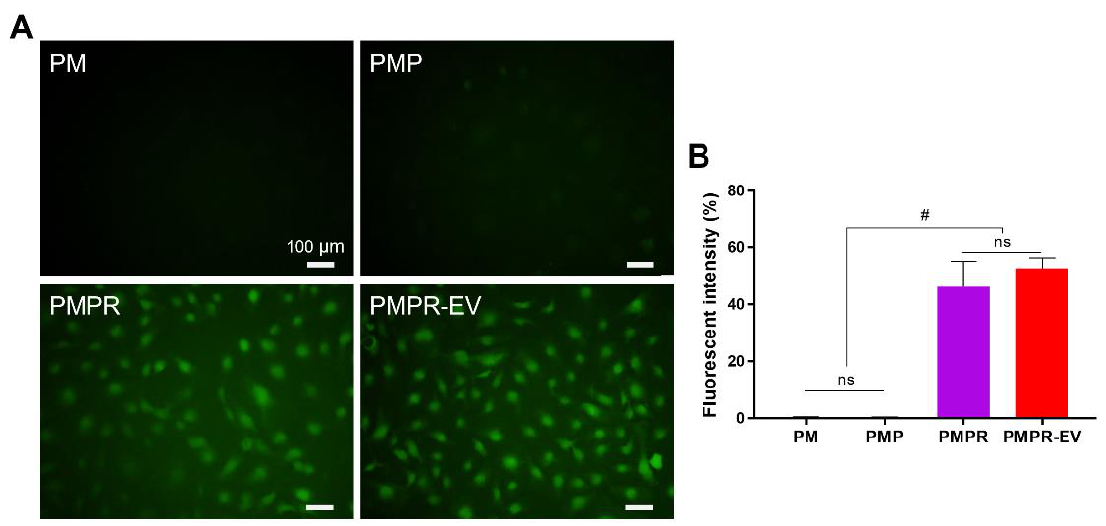
Figure 5. NO release from HUVEC onto the composites in vitro. DAF-FM stained ( A ) fluorescence images and ( B ) quantification of relative fluorescence intensity. # p < 0.0001 indicates statistically significant differences.